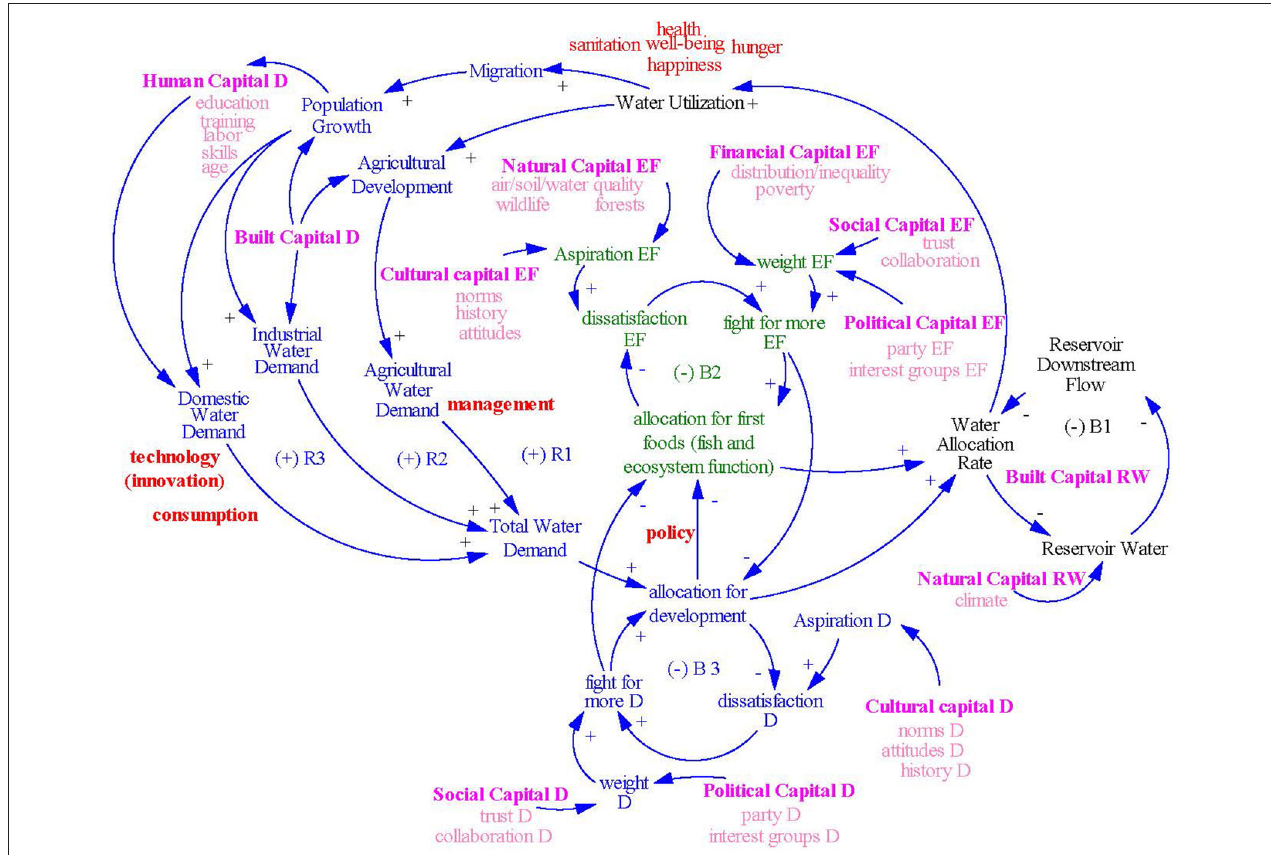
FIGURE 5 | Conceptual map of incorporated capitals into FEW systems with green text highlighting ecosystem functions and blue text indicating development aspects within the Yakima River Basin. Pink text demonstrates where community capitals influence interactions in the FEW nexus and red text shows areas that can influence intensification or alleviation of